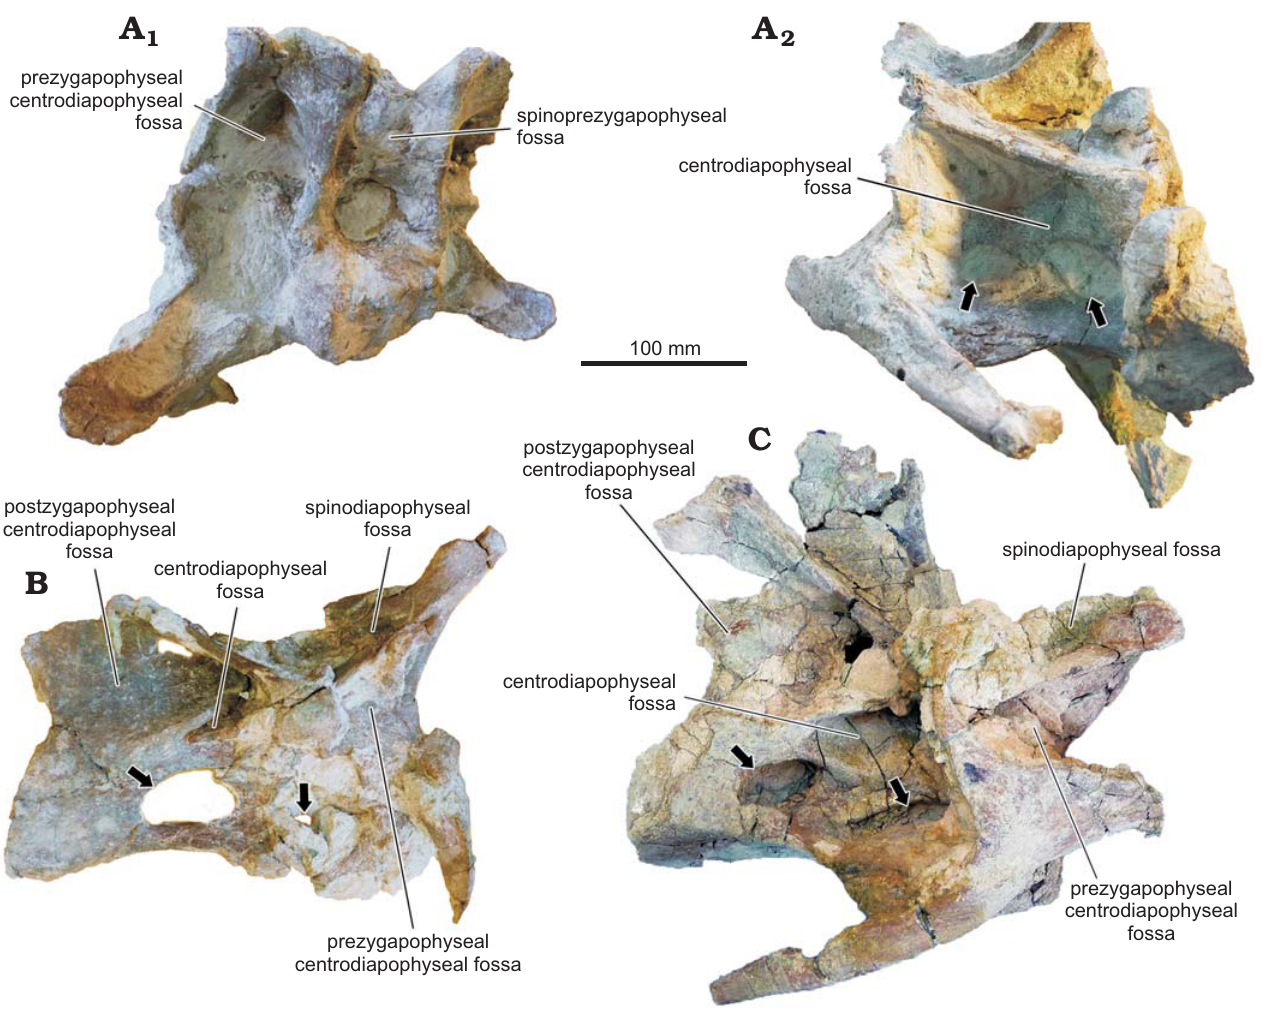
Fig. 7. Cervical vertebrae of rebbachisaurid sauropod Katepensaurus goicoecheai Ibiricu, Casal, Martínez, Lamanna, Luna, and Salgado, 2013a from the Cenomanian–Turonian Bajo Barreal Formation of Chubut Province, Argentina. A . UNPSJB-PV 1007/1, anterior cervical vertebra in anterior (A 1 ) and right ventrolateral (A 2 ) views. B . UNPSJB-PV 1007/2, anterior cervical vertebra in right lateral view. C . UNPSJB-PV 1007/3, middle cervical vertebra in right lateral view. Lateral fossae of the centrum (hypothesized as pneumatic in origin) indicated by